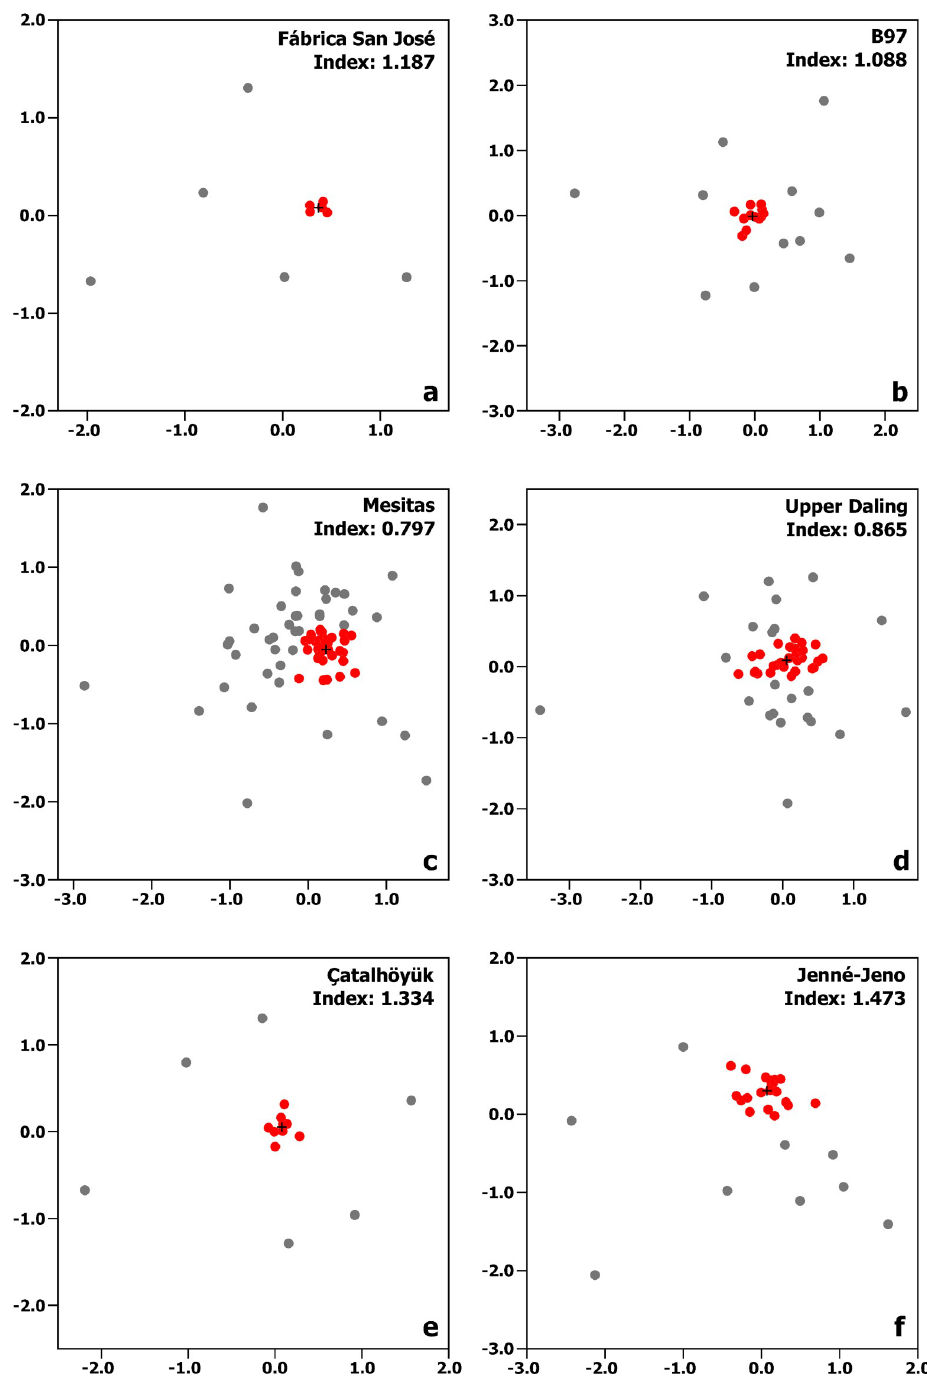
Fig 1. Multidimensional scalings of household artifact assemblages. a) Fa´brica San Jose´ (Oaxaca), b) B97 (Barinas), c) Mesitas (Alto Magdalena), d) Upper Daling (Western Liao), e) C¸atalho¨yu¨k (Anatolia), and f) Jenne´-Jeno (Middle Niger). Red points correspond to the central cluster of ordinary households in each configuration; black cross corresponds to the centroid of each central cluster. Index value corresponds to the measure of productive differentiation discussed in the